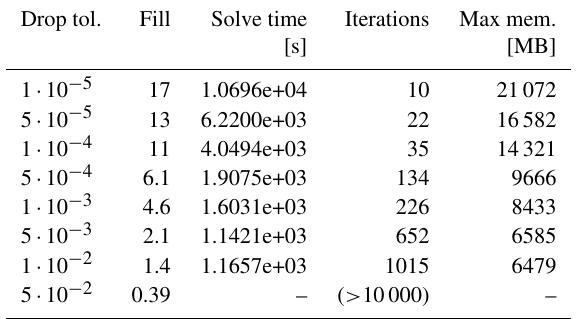
Table 2. The effect of varying the drop tolerance parameter (see Sect. 3) for a 32 3 element system and right-preconditioned GM- RES(60)/ILDL solver as in Table 1. Loosening the drop tolerance increases the iteration count and reduces the fill and hence memory footprint. Drop